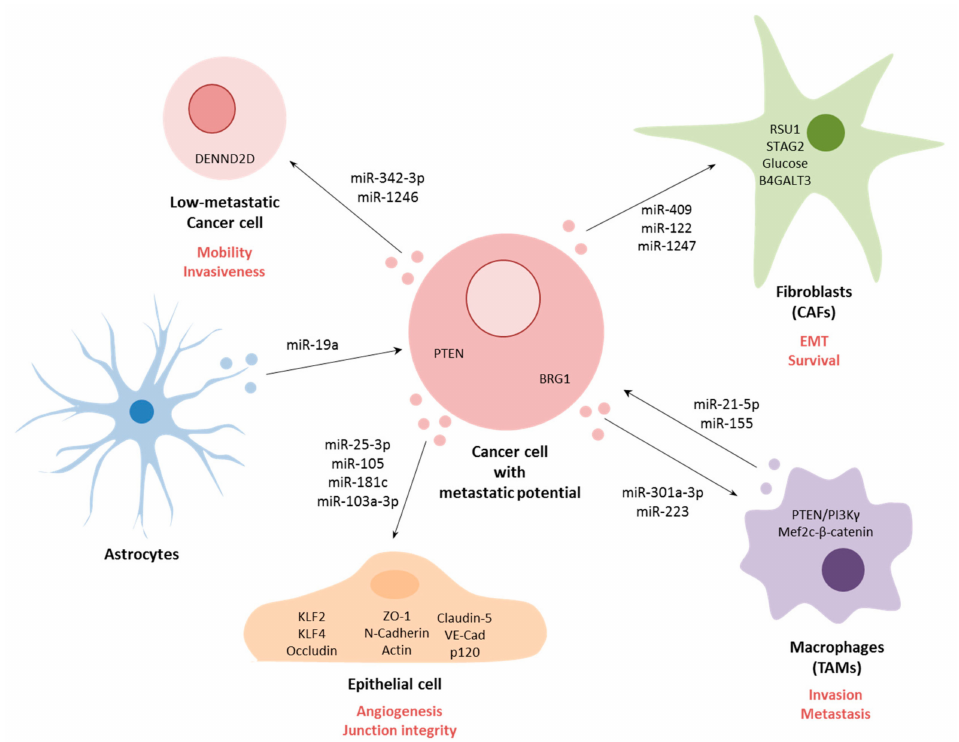
Figure 2. Cancer cell communication through extracellular vesicles (EVs). Cancer cells can communicate with surrounding cells or distant cells via miRNAs contained inside the EVs. Non-tumor cells are usually epithelial cells, macrophages or fibroblasts, although, communication between cancer cells with low-metastatic potential with astrocytes has also been described. Schematic representation of miRNAs involved in each communication and targets described in receptor